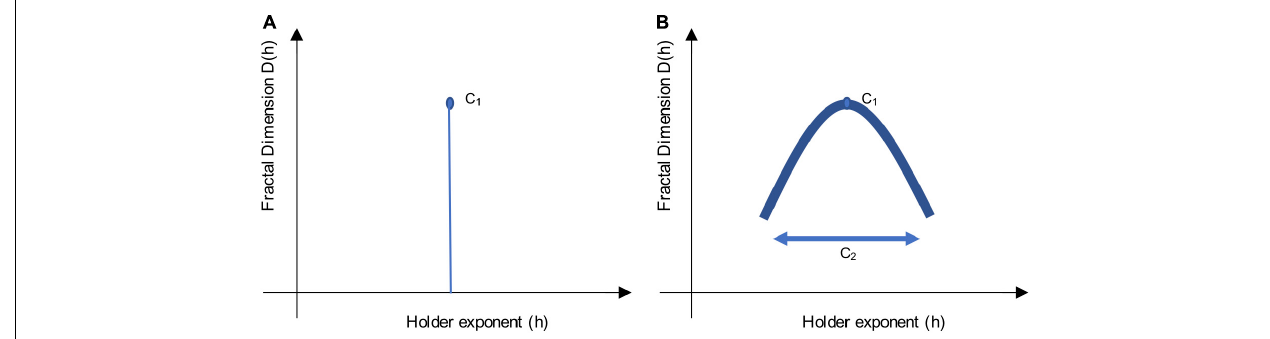
FIGURE 1 | Sketch of a singularity spectrum. These sketches illustrate the multifractal scaling function, which depicts a singularity spectrum. Local variability in the signal is represented by Hölder exponents, h, on the x -axis, while the amount of singularities is represented by the Fractal Dimension, D(h), on the y -axis. The apex of the curve reveals the most common h exponent, while the width of the curve reveals the multifractal spectrum. Using log-cumulants from the WLBMF (described in section “Defining Parameters of Log-Cumulants”) to describe the singularity spectrum, C1 informs on the apex, while C2 informs on the width of the function. (A) Shows a monofractal function, where C1 = H, the Hurst exponent, and C2 = 0. (B) Shows a multifractal function, where the concavity shows the distribution of h